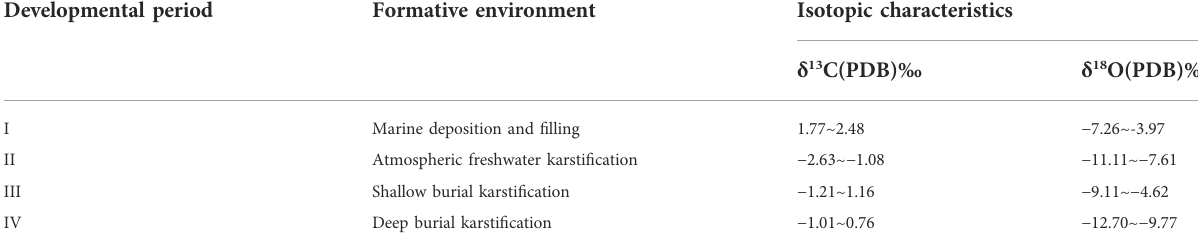
TABLE 2 Paleokarst developmental periods and characteristics of corresponding fi lling